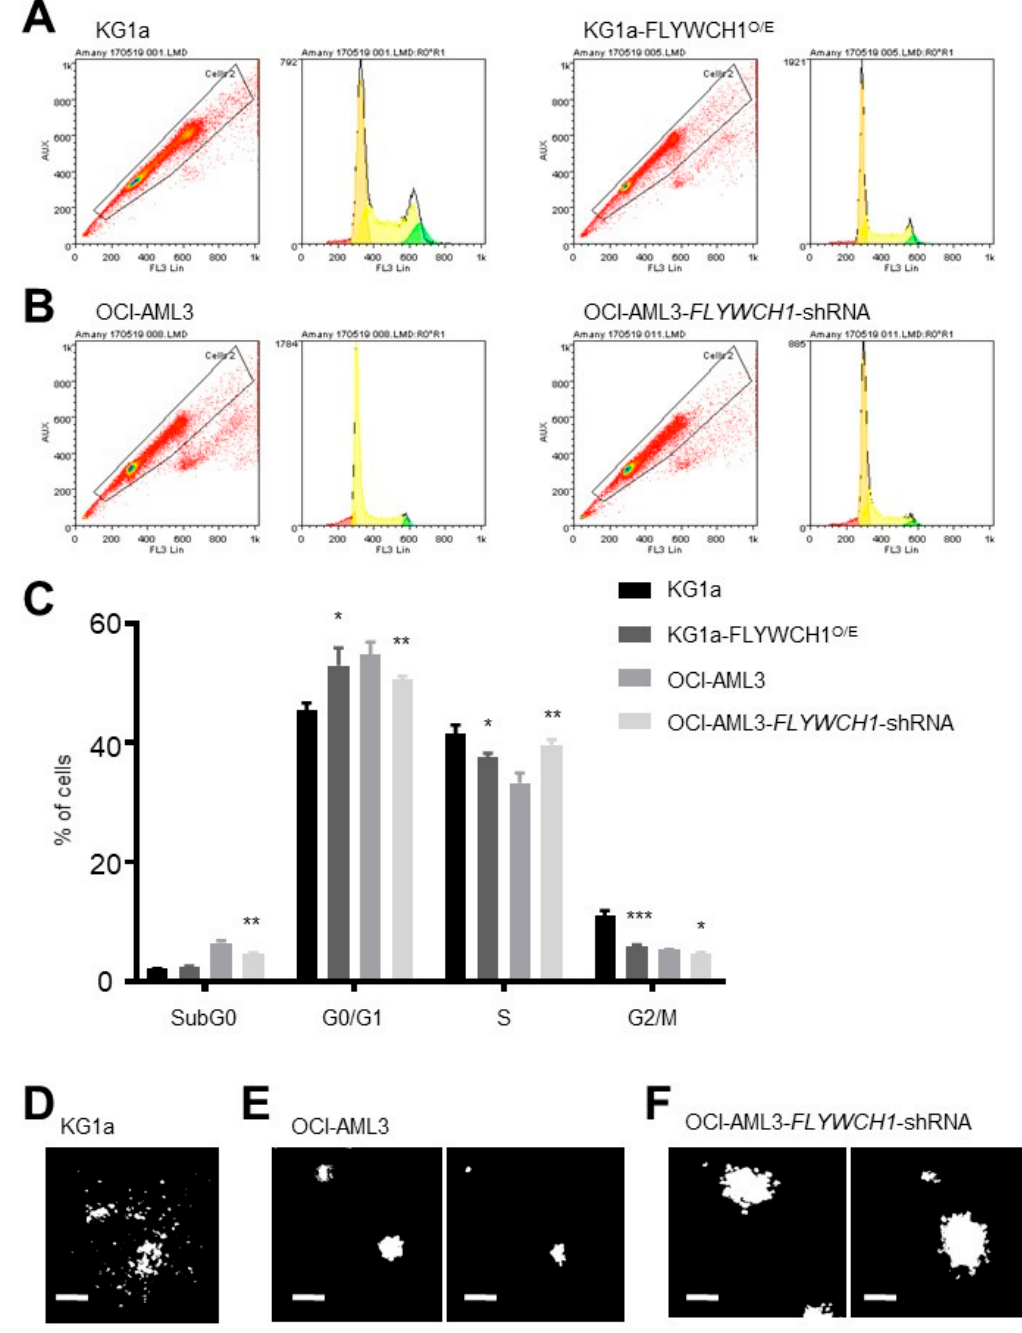
Figure 4. FLYWCH1 plays a role in AML cell growth. ( A , B ) Panels show the representatives of flow cytometry and Propidium iodide (PI) staining analysis of ( A ) KG1a control and FLYWCH1 overexpressing, and ( B ) OCI-AML3 control and FLYWCH1 -shRNMA expressing cell lines. ( C ) The cell cycle status of KG1a and OCI-AML3 cells was monitored via flow cytometry and PI staining in triplicates. Error bars present mean ± SEM of three independent experiments (* p < 0.05; ** p < 0.01; *** p < 0.001). ( D – F ) Representative images of ( D ) scattered cell aggregates of KG1a cells and ( E ) colonies from OCI-AML3 control, and ( F ) FLYWCH1 -shRNMA expressing cell lines. Images were captured at × 10